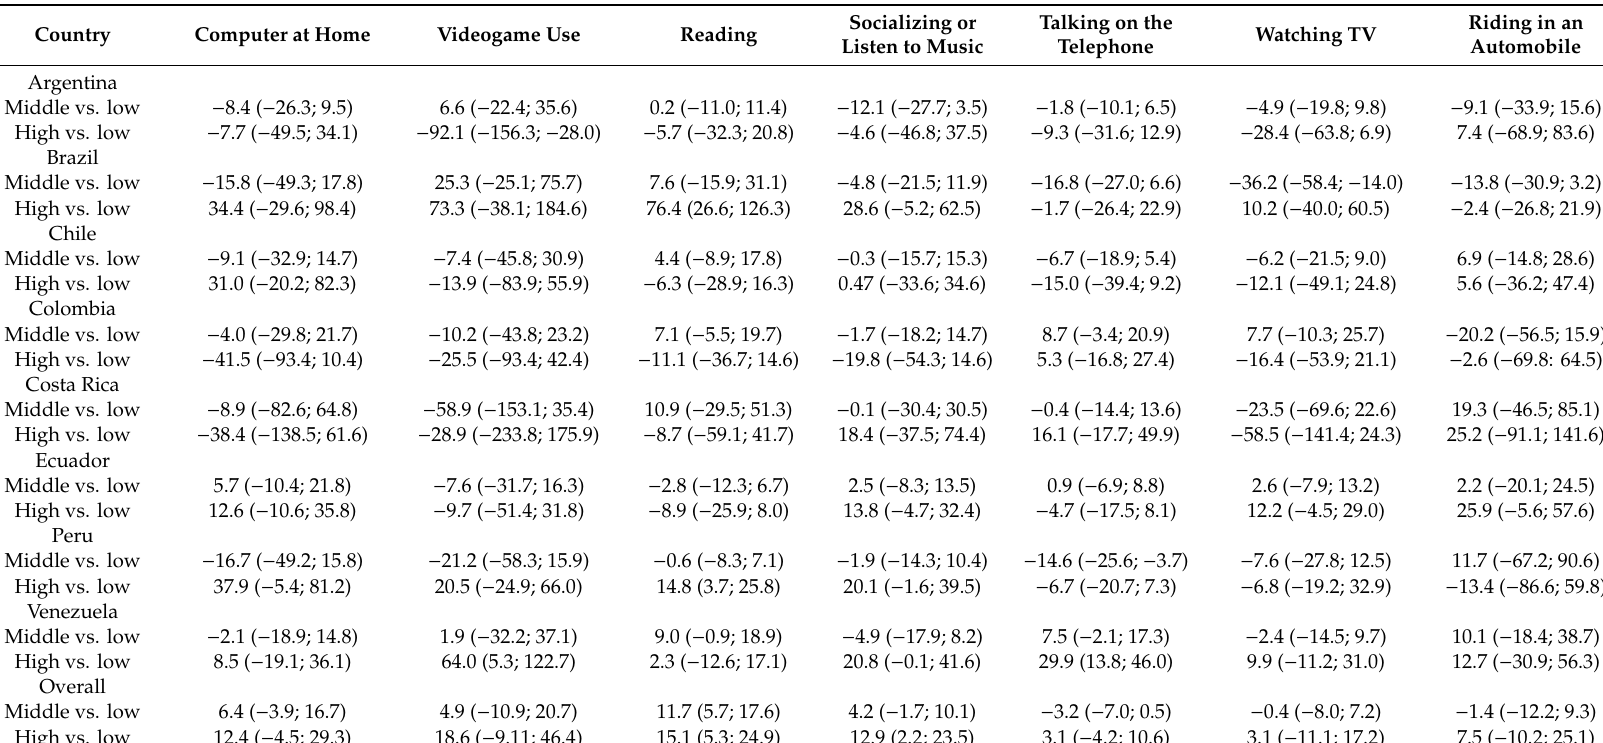
Table 6. Adjusted analyses ( b coe ffi cient (95% CI)) between socioeconomic level and sedentary behavior by country for specific-domains. Country Computer at Home Videogame Use Reading